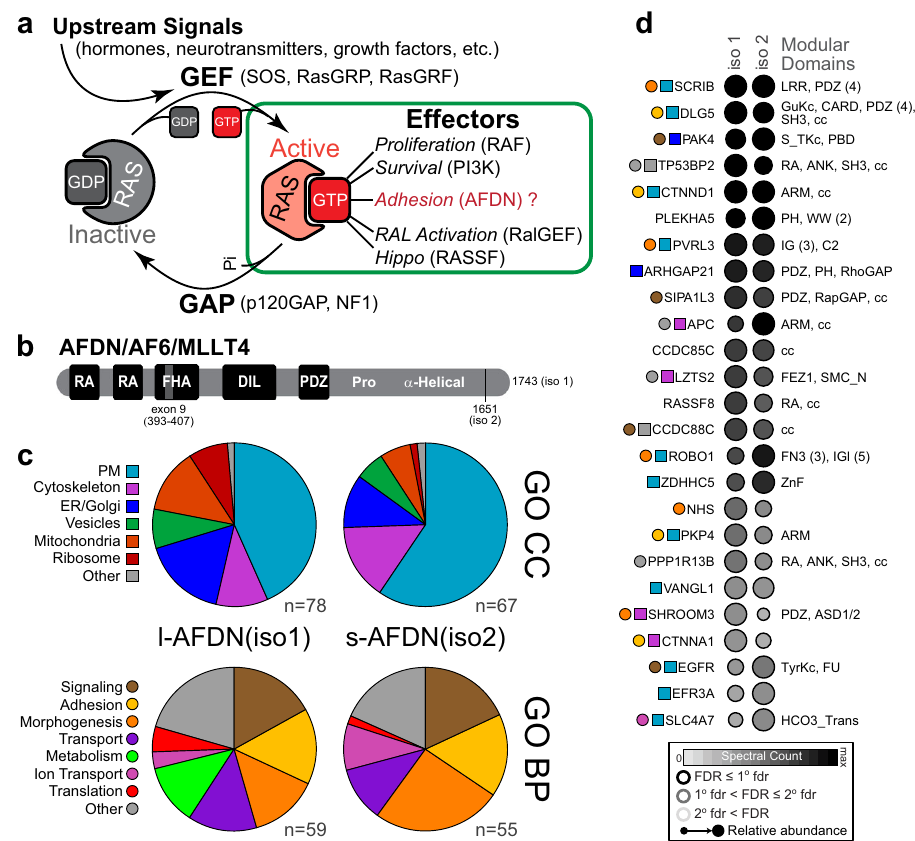
Fig. 1 | BioID identi fi cation of proteins with in vivo proximity to AFDN. a Activationof RASsubfamilysmall GTPases isgoverned by differential binding to guanine nucleotides. In the GTP-bound state RAS interacts with effector proteins, includingAFDN. b DomainorganizationoftheAFDNprotein.RA=RASAssociation domain; FHA=forkhead-associated domain; DIL=dilute domain; PDZ=PSD95/ DLG1/ZO-1 domain. These are followed by a proline rich region and a C-terminal